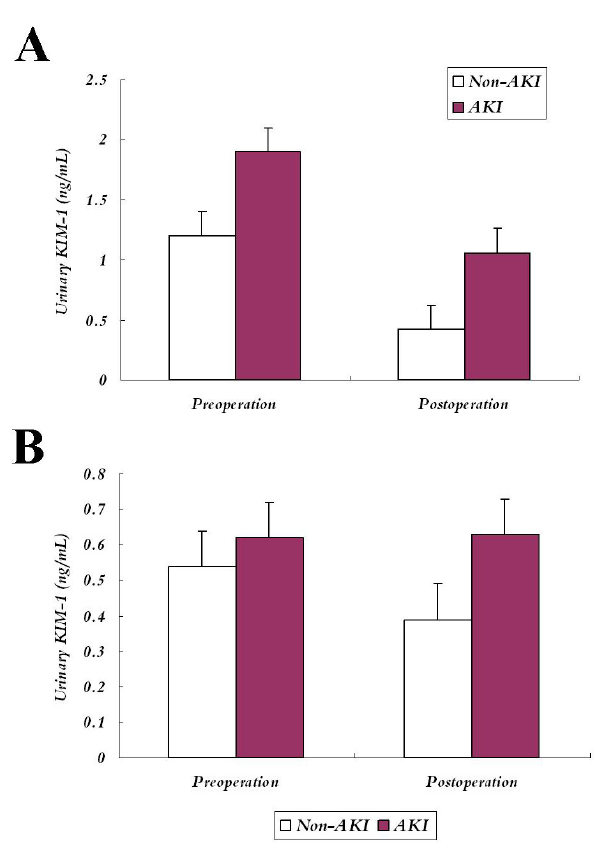
Fig. 3 – A comparison of kidney injury molecule 1 (KIM-1) between acute kidney injury (AKI) and non-AKI patients during postoperative period: (A) in adult and (B) in pediatric patients. *P<0.05 between AKI and non-AKI